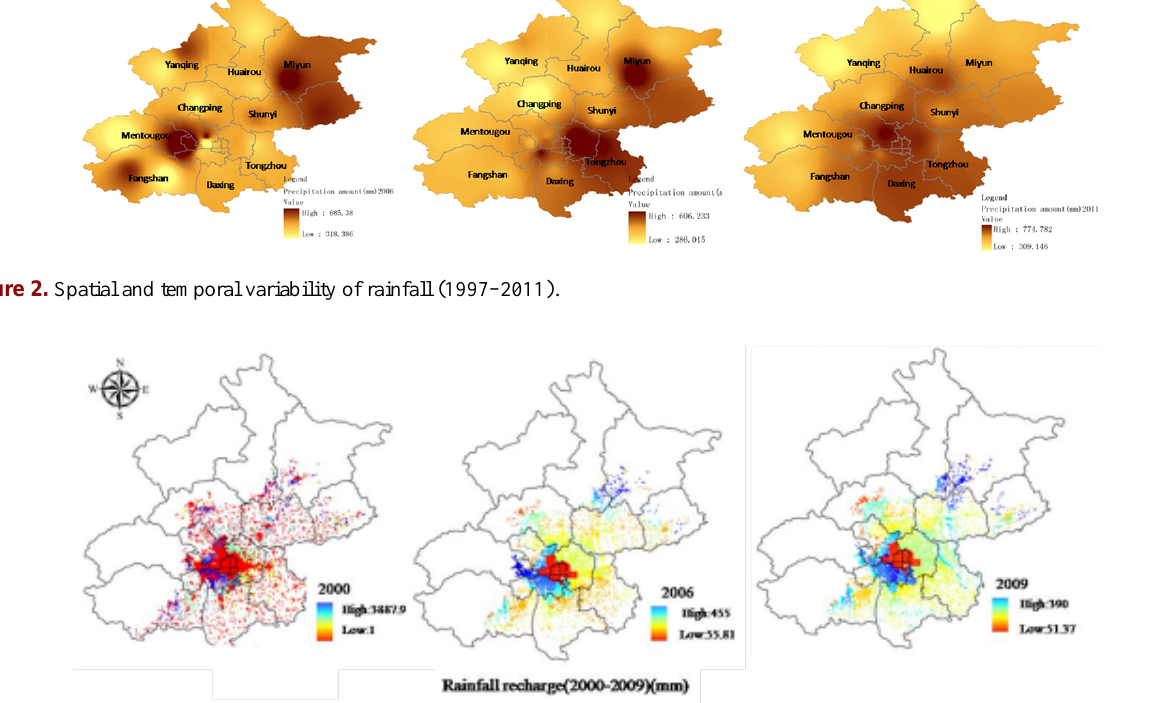
Figure 3. Spatial-temporal distribution of effective recharge to groundwater from rainfall